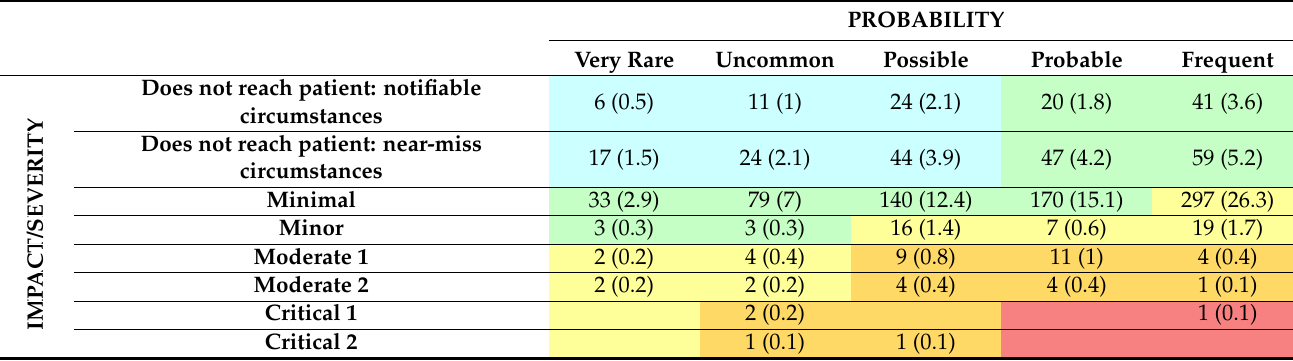
Table 2. Distribution of type of incidents notified according to probability and impact or severity of damage (risk matrix).